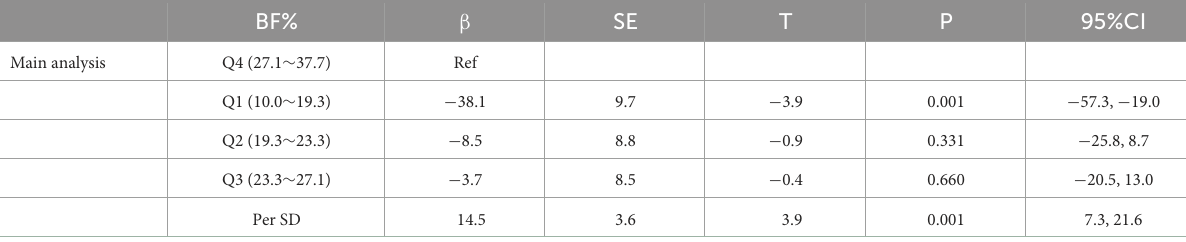
TABLE 3 Generalized linear analysis results of the between-group difference of 1 baPWV with BF%. BF%